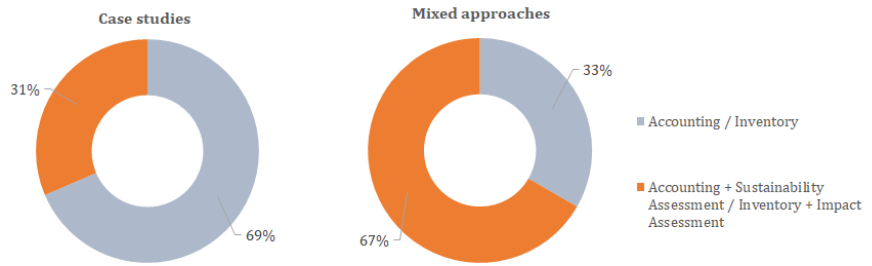
Figure 8. WF phases and water components evaluated in case studies and mixed approaches.